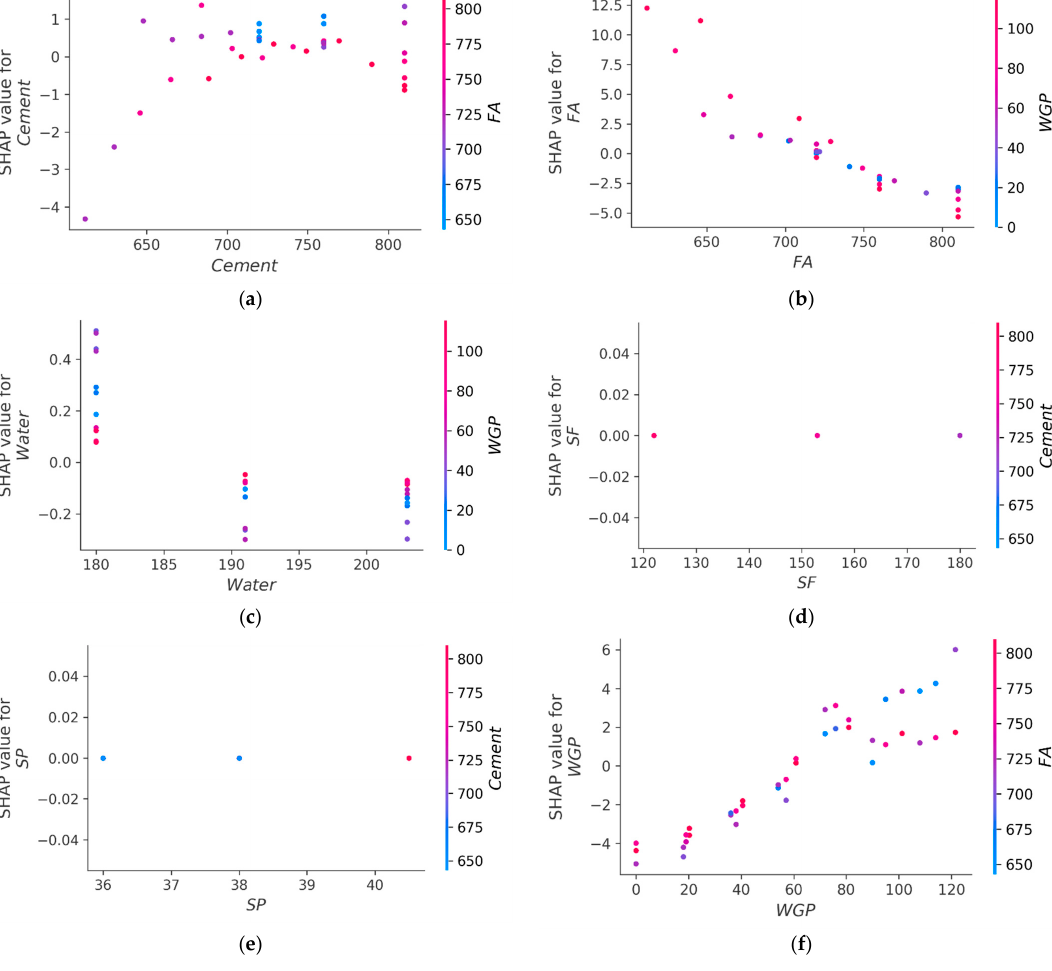
Figure 14. Interaction of raw ingredients and their impact on CS and FS: ( a ) cement; ( b ) fine aggregate; ( c ) water; ( d ) silica fume; ( e ) superplasticizer; ( f ) waste glass powder.